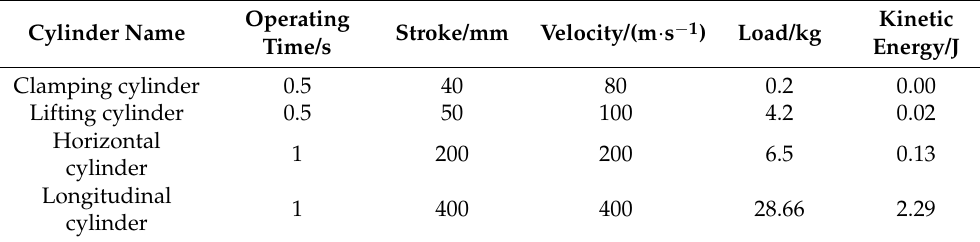
Table 3. Calculation results of kinetic energy (Note: Data are obtained by kinetic energy formula).